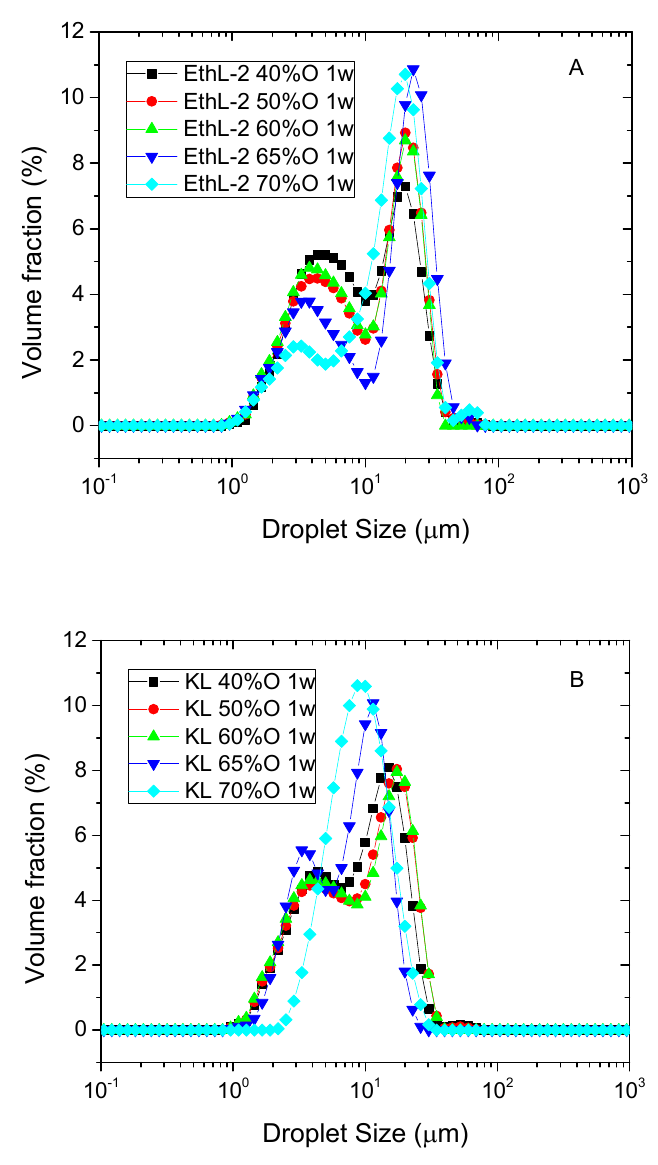
Figure 2. Effect of silicone oil concentration on droplet size distribution of emulsions stabilized by 0.5 wt.% bioethanol ( A ) or Kraft lignin ( B ) at pH = 13, after one week storage. 0.5 wt.% bioethanol ( A ) or Kraft lignin ( B ) at pH = 13, after one week